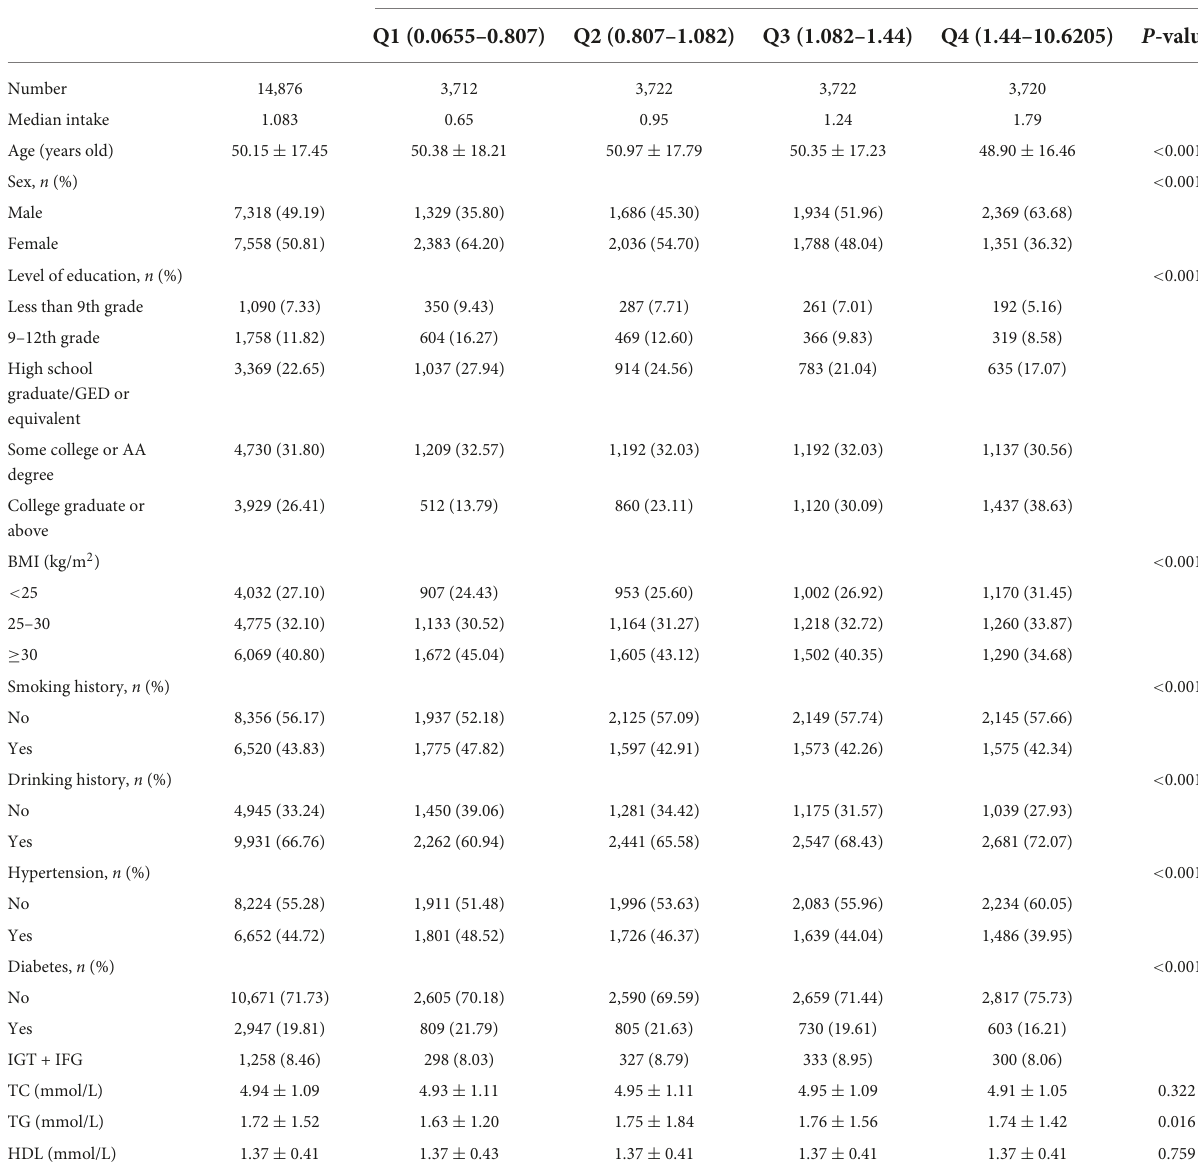
TABLE 1 Baseline characteristics of total participants according to copper intake